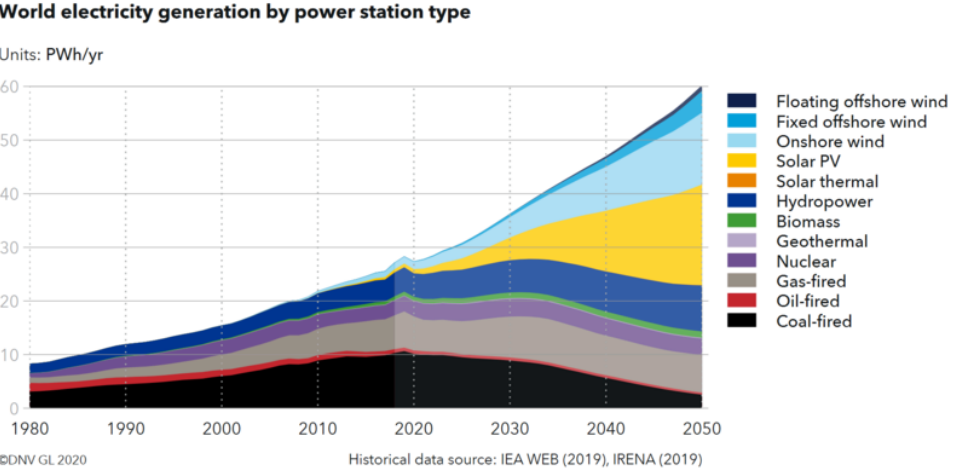
Figure 1. Floating wind will deliver 2% of the world’s power supply until 2050. Source: IEA web